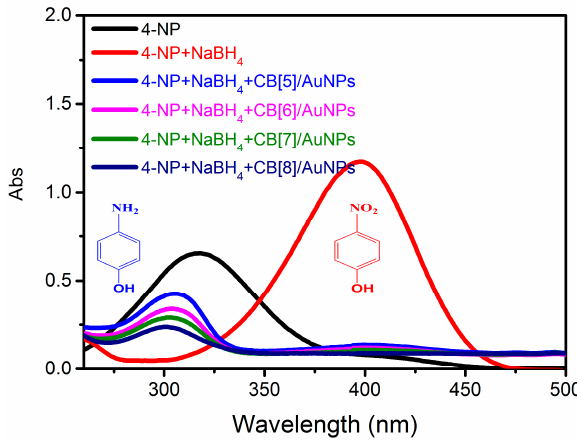
Figure 3. UV-VIS spectra of 4-NP reduction catalyzed by CB[ n ]/AuNPs at 25 °C.